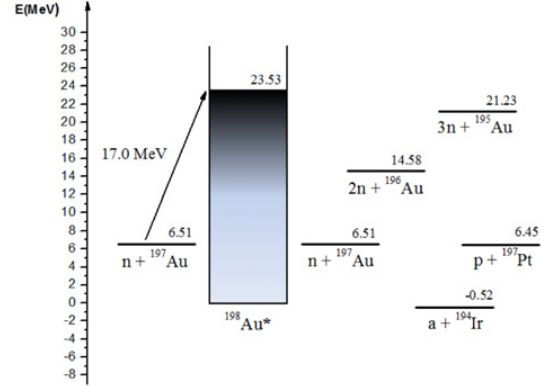
Figure 1. Energy diagram of the n + 197 Au interaction.